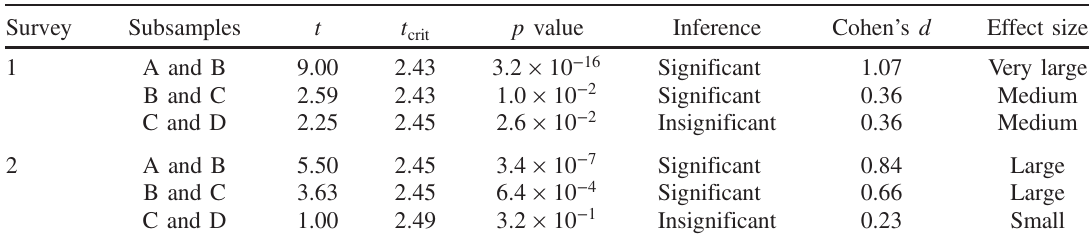
TABLE V. Pairwise t tests and Cohen ’ s d between epistemic scores of students grouped by academic marks. Survey